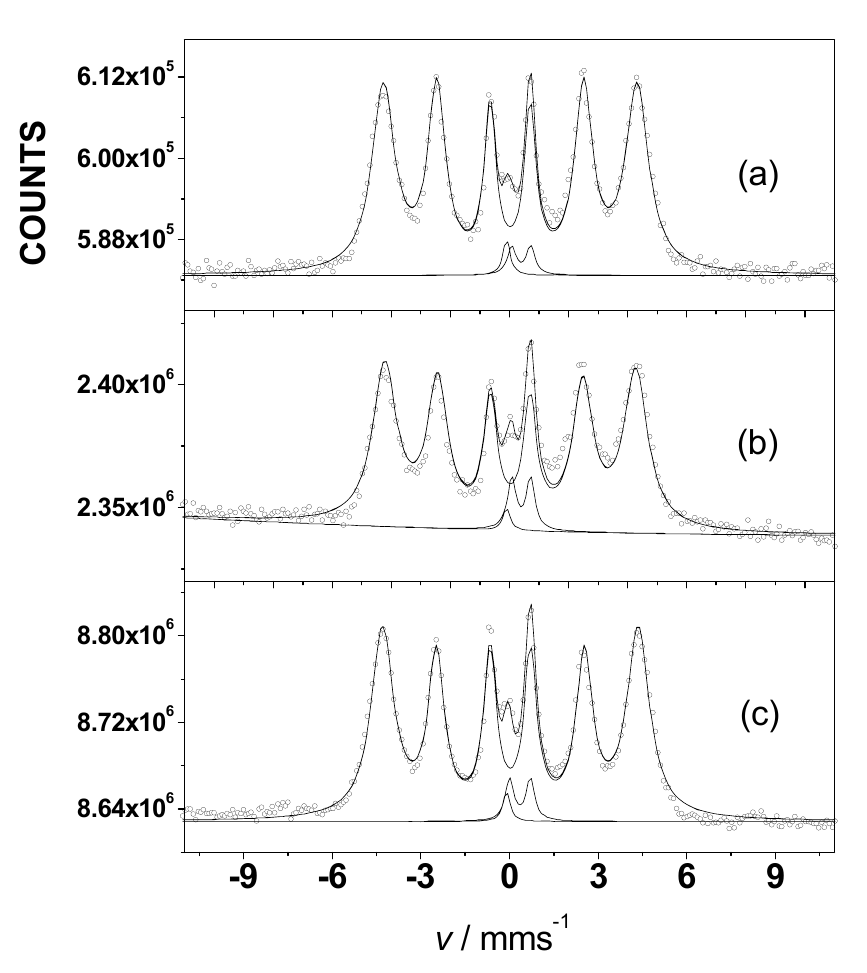
Fig. 3 M¨ossbauer spectra of electrodeposited sample A: (a) passivated at 0.25 V vs sce for 100 minutes; (b) after potential square wave cycling between –0.7 and +0.3 V for 30 minute (duration of the cathodic and anodic pulse was 0.2 and 0.2 s, respectively), and (c) after prolonged corrosion in 0.3 M Na